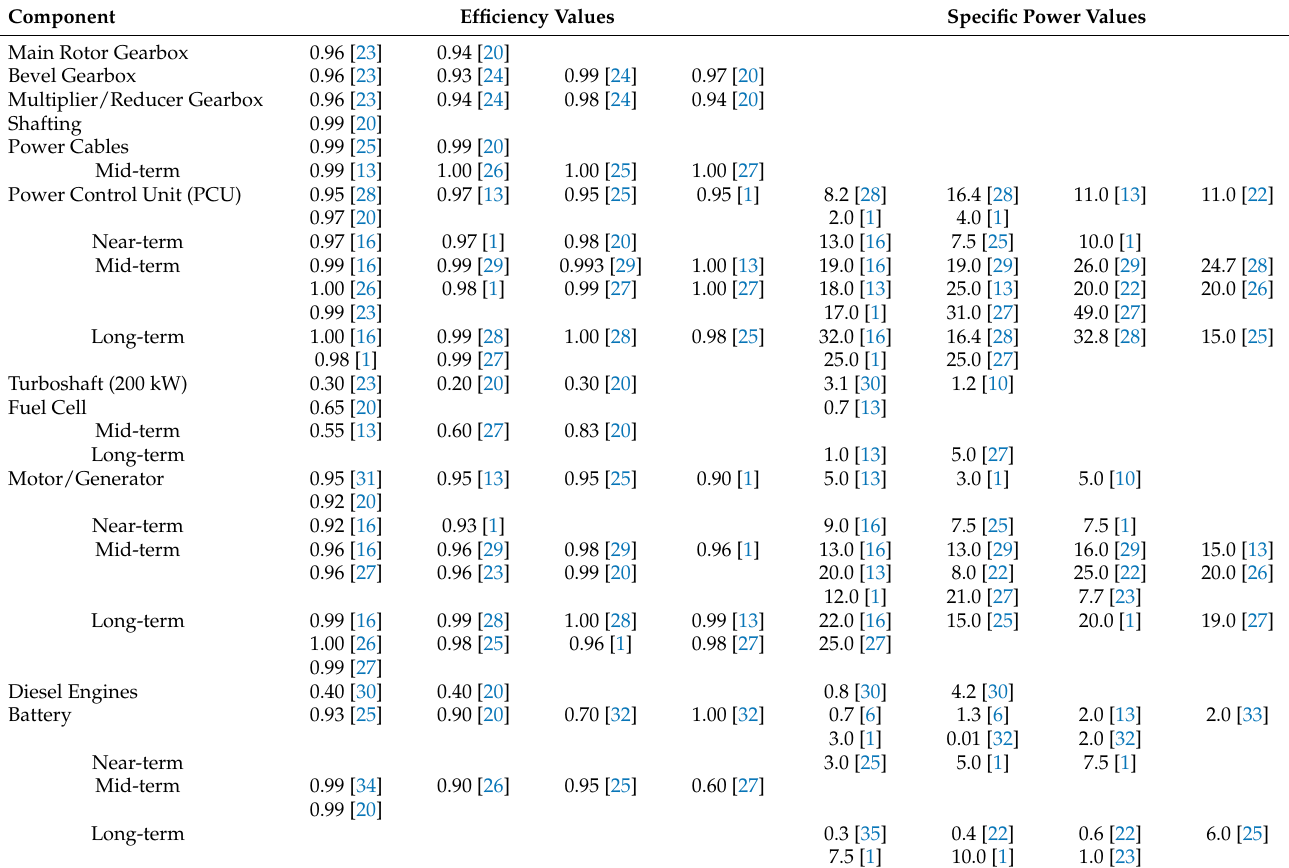
Table 1. Efficiency and specific power values found from literature.